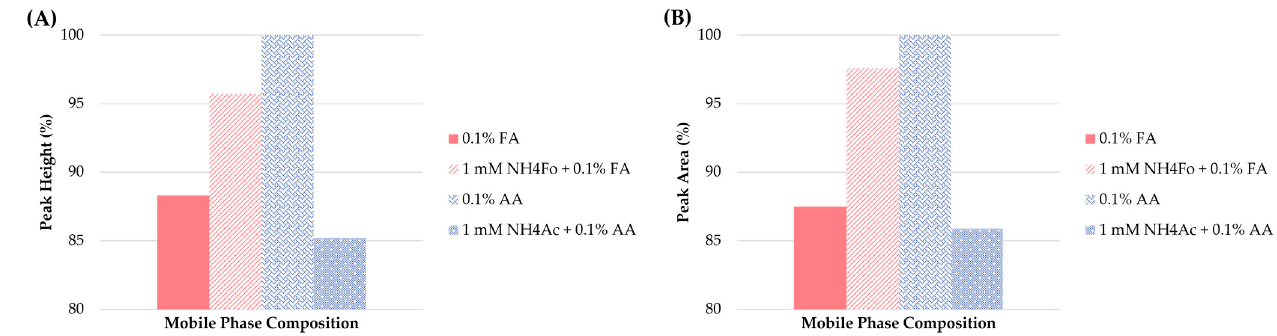
Figure 4. Influence of different mobile phase additives on ( A ) peak height and ( B ) peak area of clenbuterol.